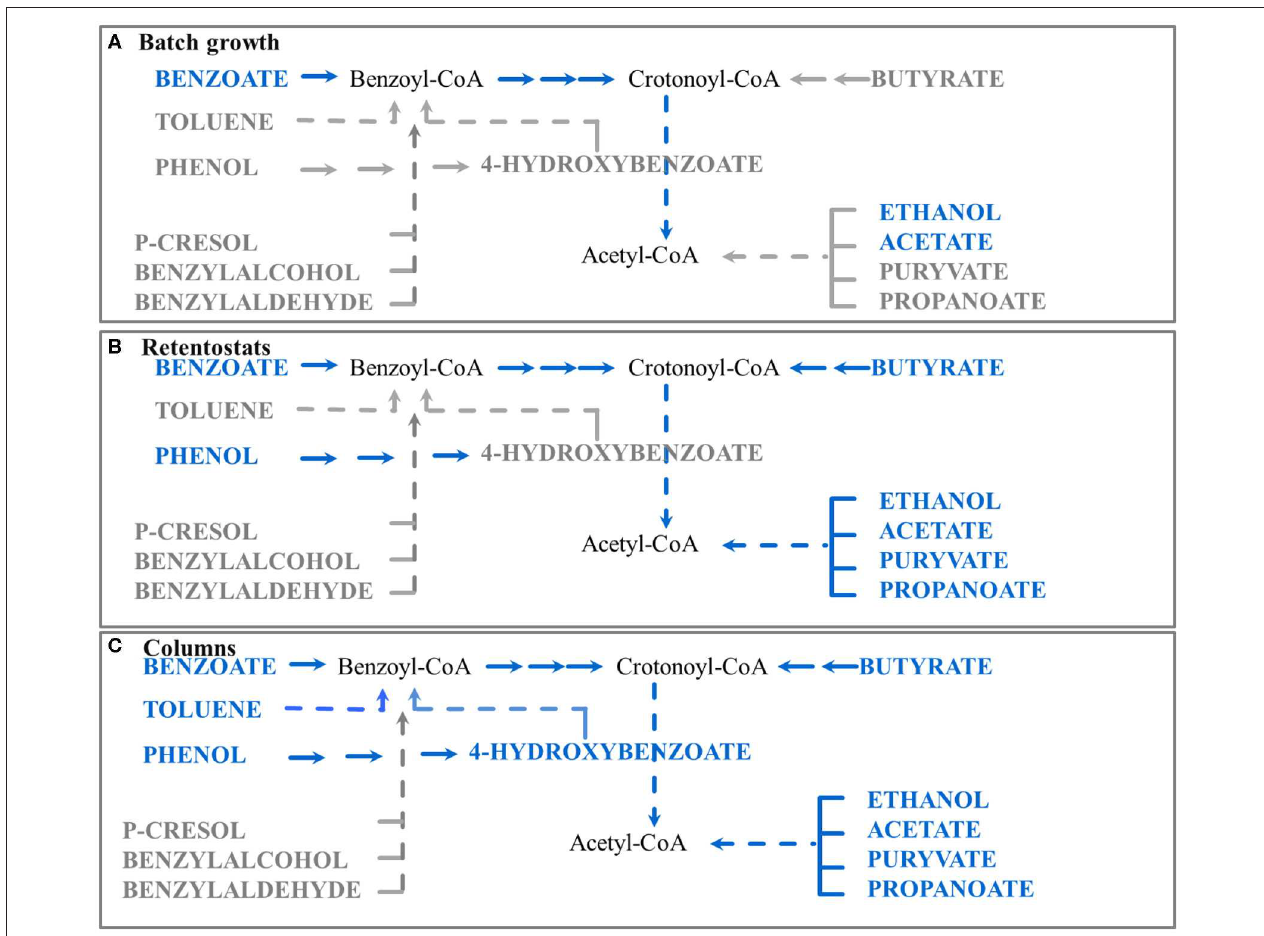
FIGURE 4 | Schematic representation of the proposed regulation of catabolic pathways by G.metallireducens under different conditions studied to date (batch, retentostat, and sediment column). Blue color represents substrates which are readily used by G. metallireducens , gray color represents substrates where degradation might need specific induction and no proteins were detected for their degradation. Proteins of the corresponding pathways were detected in (A) batch experiments with benzoate as a carbon source ( Marozava et al., 2014a); (B) retentostats with acetate plus benzoate as carbon sources (Marozava et al., 2014b); (C) columns with benzoate as a carbon source (this